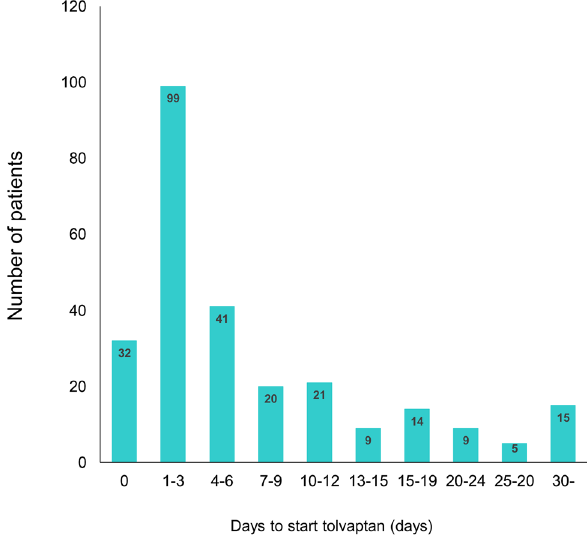
Figure 1. Timing of tolvaptan usage during the index hospitalization. The median time of initiation of tolvaptan from hospitalization was 3